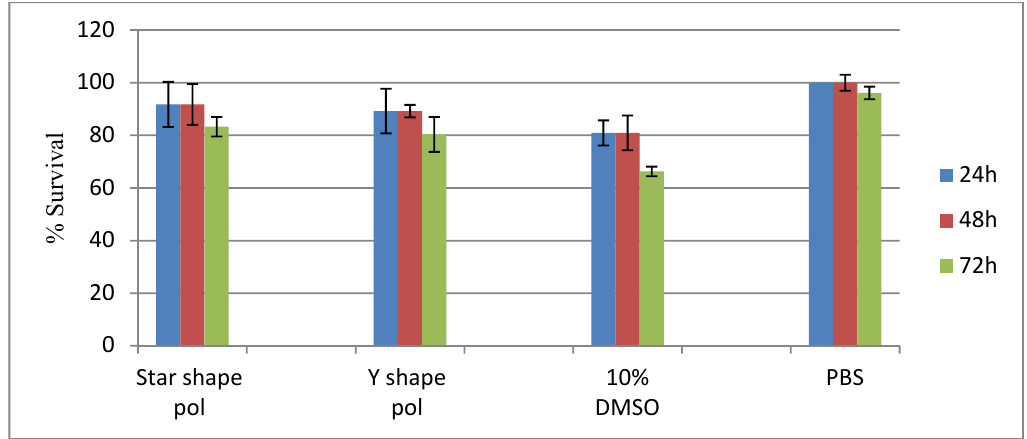
Figure 15. Cytotoxic activity of positive and negative controls on MCF-7 cells in 24, 48 and 72 h.